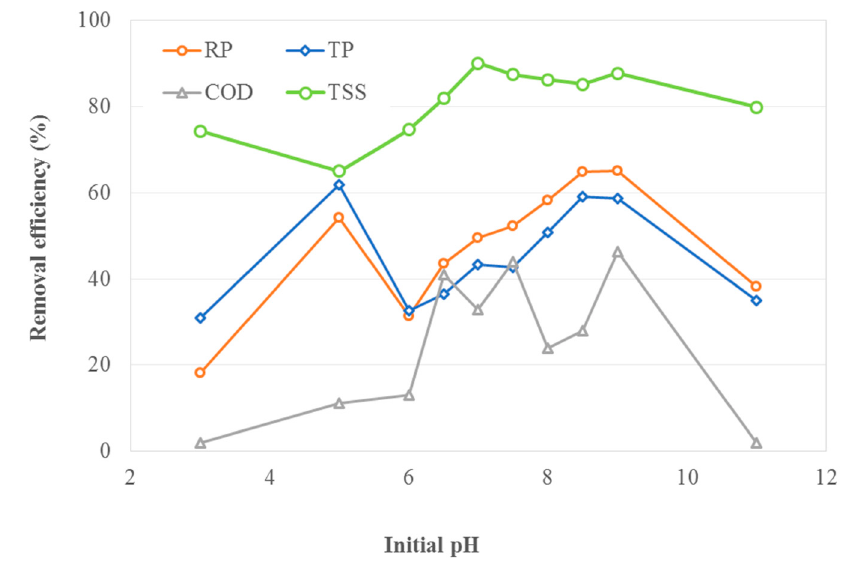
Figure 2. E ff ect of initial pH on removal e ffi ciency (5 W and 20-min treatment Figure 2. Effect of initial pH on removal efficiency (5 W and 20-mins treatment time).